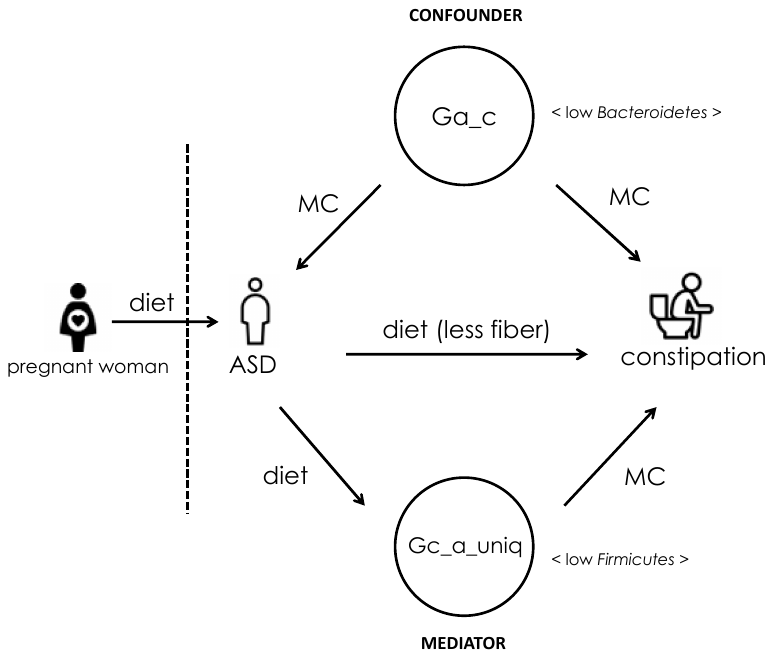
Figure 6. The hypothetical causal relations between ASD, gut microbes, and constipation. MC: metabolic change.